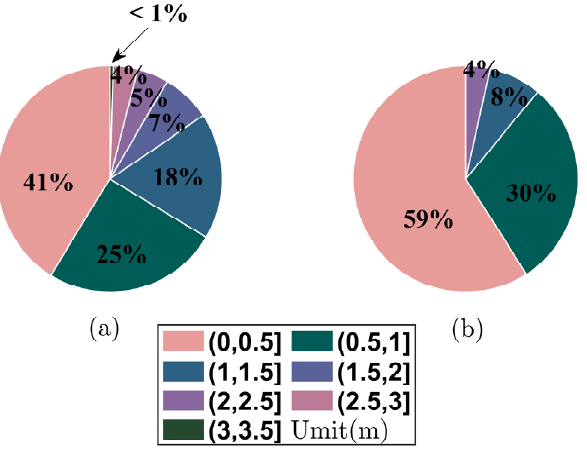
Figure 11. Absolute errors of the joint inversion method and the sea clutter inversion method.